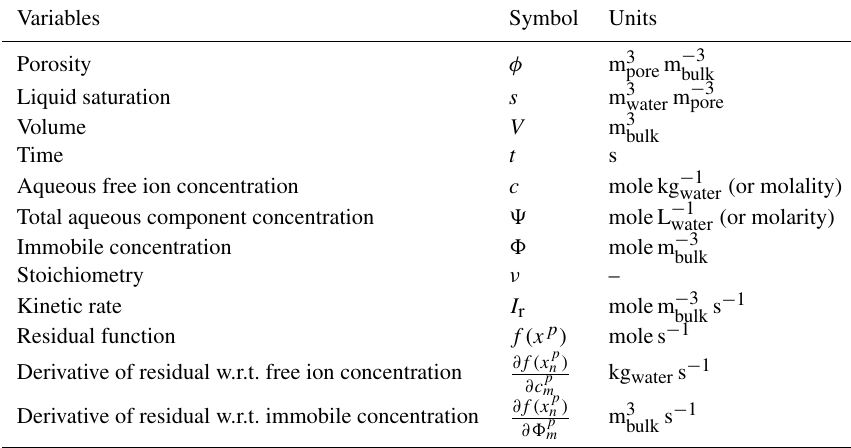
Table 1. Units for PFLOTRAN internal